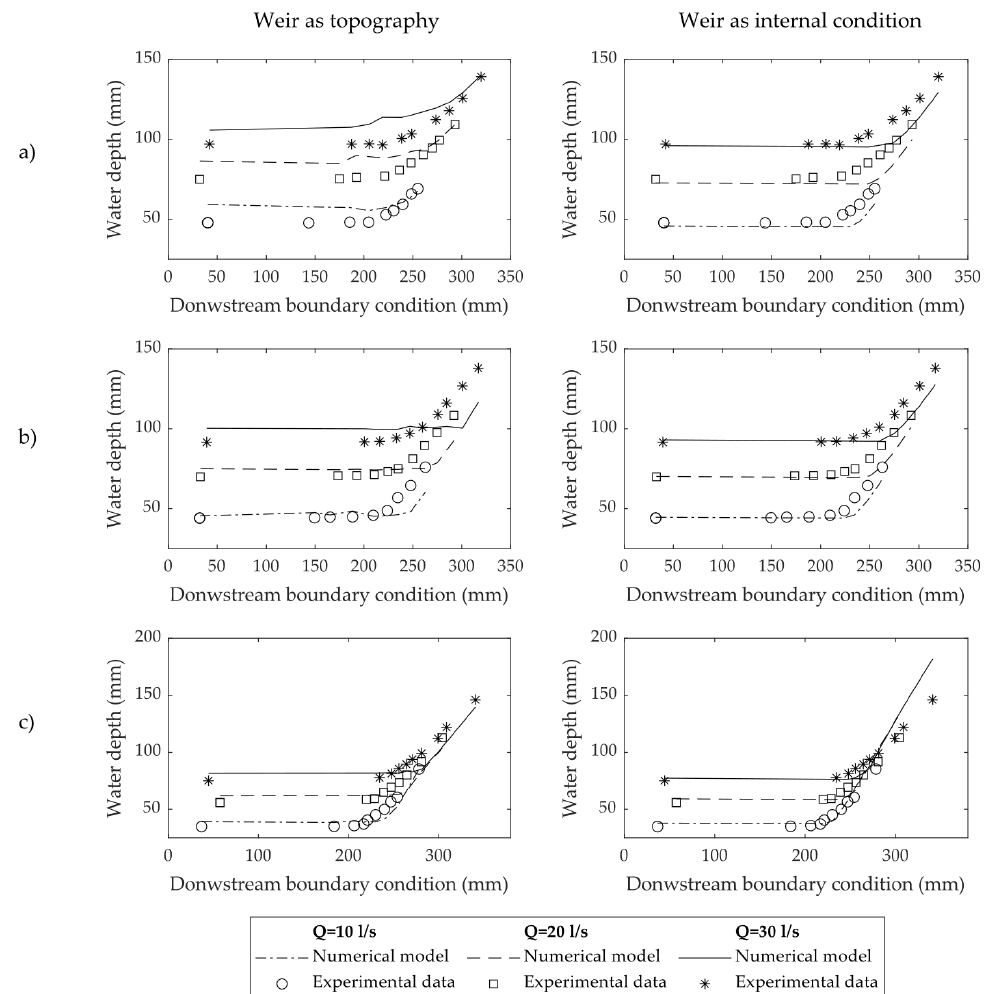
Figure 10. Comparison of the water depth result obtained by the numerical model and its corre- sponding value from the experimental test for Weir 3 ( a ), Weir 4 ( b ) and Weir 9 ( c ). Water depth measurement was taken at the control point (CP) and refers to the depth above the crest of the weir. Flow values have been simplified for the understanding of the results. The reader is referred to Appendix A for a detailed description of the test